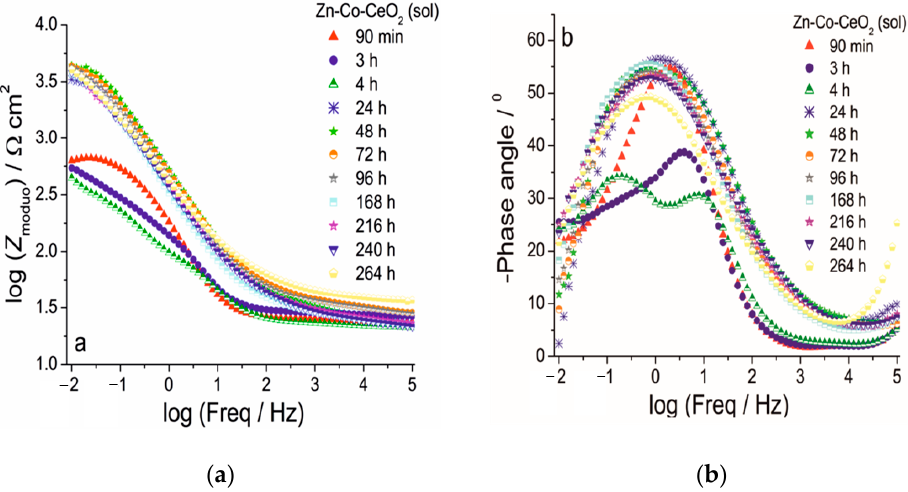
Figure 14. The Bode ( a ) modulus and ( b ) phase angle plots for Zn-Co-CeO 2 (CeO 2 sol) coating dur- ing exposure to NaCl